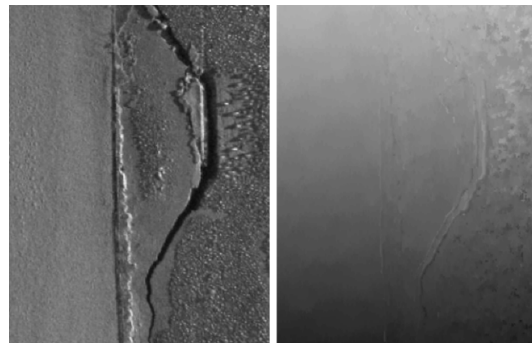
Figure 4. A detail of the left image of a stereo-pair and the corresponding disparity map.